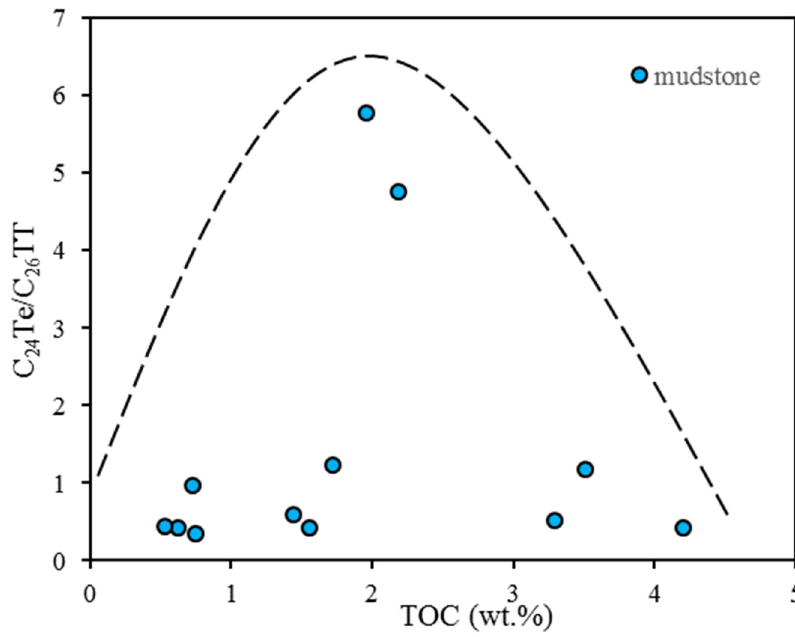
Figure 15. Relationship between C 24 Te/C 26 TT and TOC for dark mudstone.